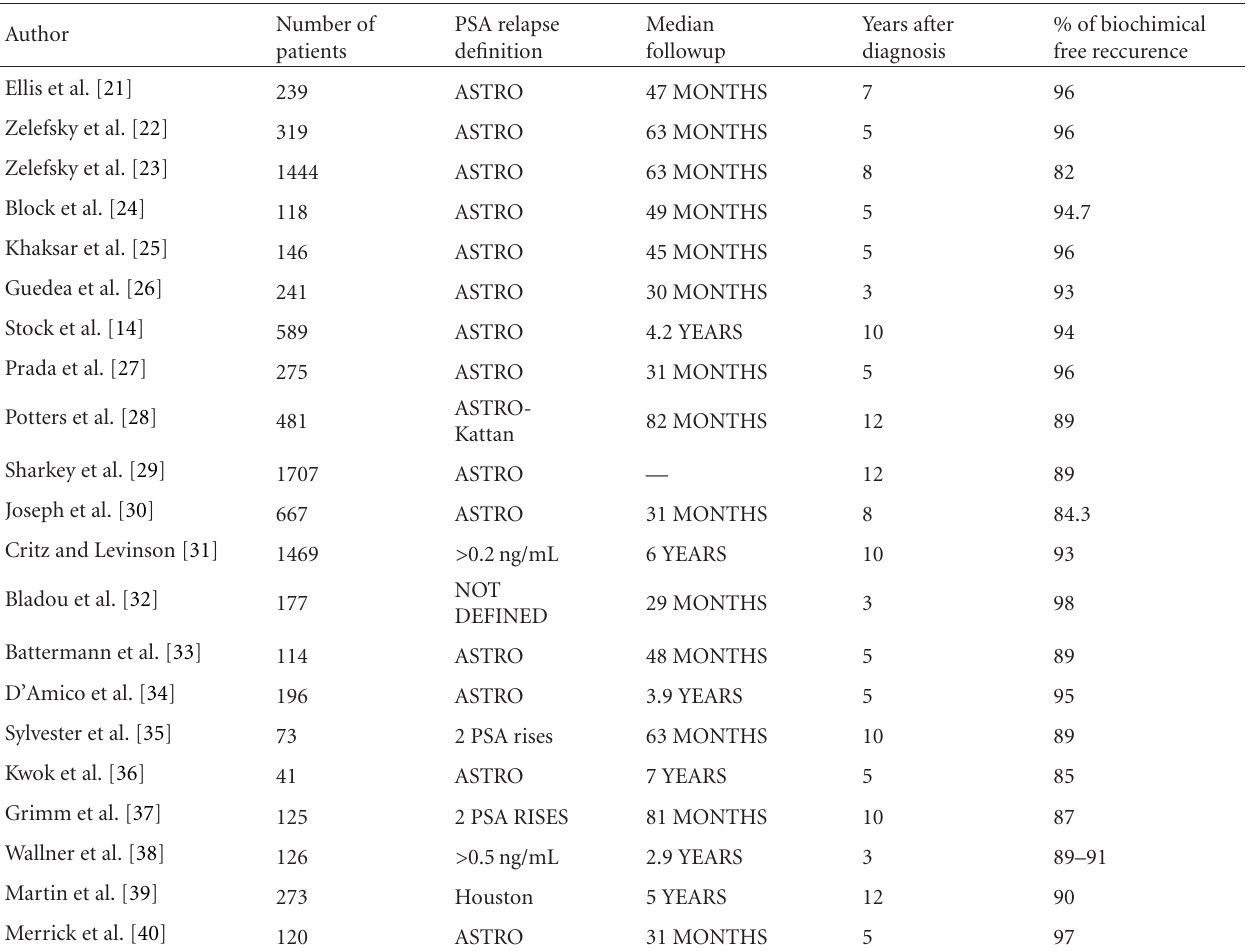
Table 1: LDR brachytherapy: clinical results for patients with low-risk prostate